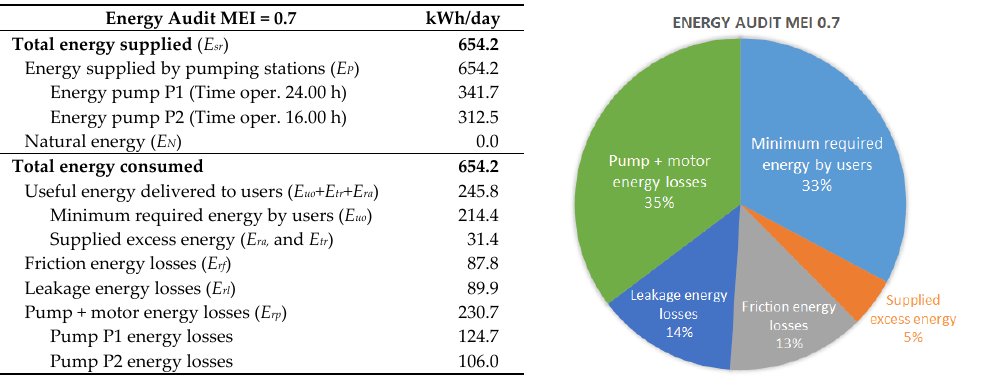
Figure 9. Energy audit result with a MEI = 0.7 pump (one CSP and one VSP).